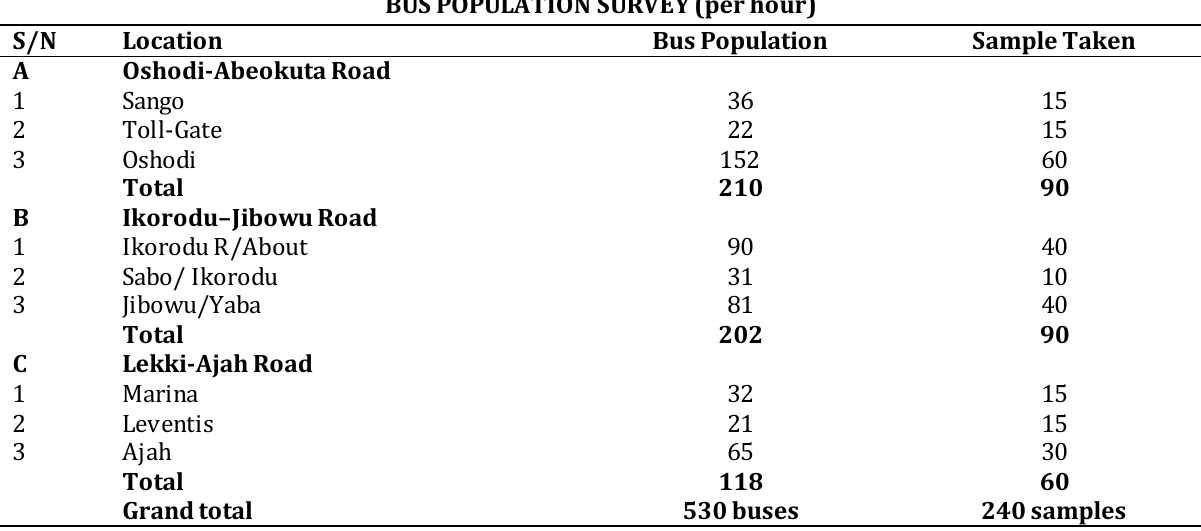
Table 2: Buses survey and sample size selection